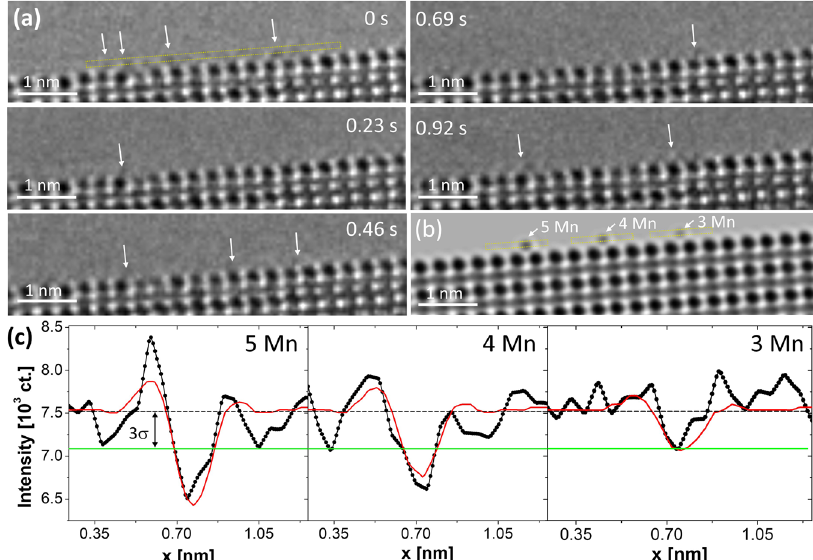
Fig. 3 Observation of dynamic Mn adatoms on a LSMO (001) surface in 0.5 Pa of H 2 O at [110] zone axis. a Time sequence of HRTEM images taken at 4.4 fps at negative defocus. Mn-adatom contrast appears and disappears on a stable La(Sr)O surface layer as indicated by white arrows. b Simulated HRTEM image with Mn-adatom column occupation of 3, 4, and 5. The Mn columns are located at interstitial surface positions on an A-terminated sample. Lamella thickness is 4.2 nm. c Line pro fi les of simulated (red) and experimental (black with symbols) images of B-columns with 3, 4, and 5 Mn atom occupation. The 3 σ threshold indicates the detection limit of Mn columns above noise level, i.e., triple Mn occupation at a B-layer column. The time sequence gives a lower limit of the Mn-adatom hopping rate of r ≥ 4 s − 1